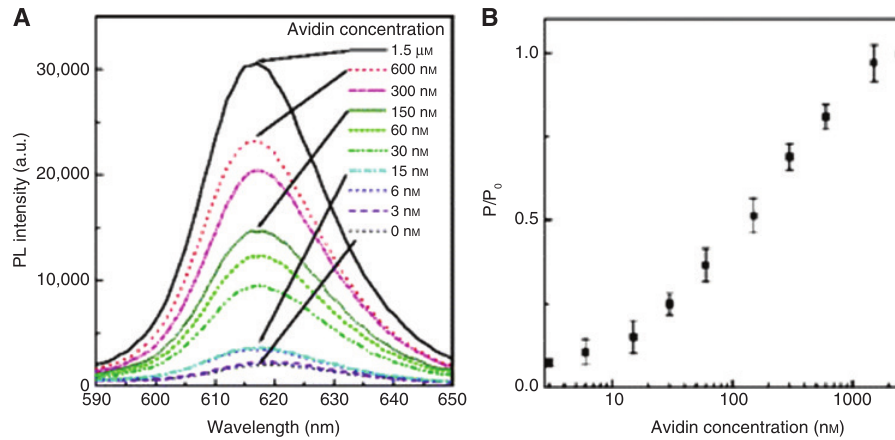
Figure 23: Detection of avidin using biotin-AuNPs and streptavidin-QDs. (A) Increase in fluorescence intensity with increasing avidin concentration for a system consisting of streptavidin-functionalized QDs interacting with biotin-functionalized AuNPs. In the absence of avidin, the biotin and streptavidin interact, leading to the quenching of the QD. Avidin addition causes the displacement of the AuNPs and fluorescence is restored. (B) Fluorescence intensity vs. avidin concentration, showing the sensitivity and detection ability of the system. Reprinted with permission from Ref. [57]. Copyright 2005 American Chemical